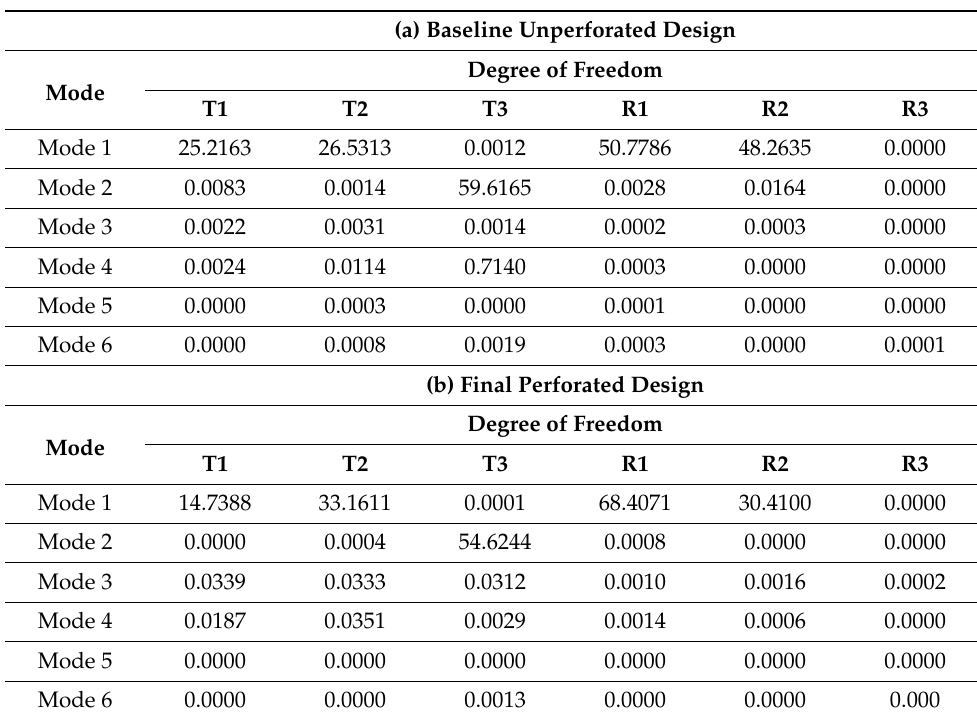
Table 8. Comparison between the effective modal mass fractions of the baseline unperforated and final perforated designs.